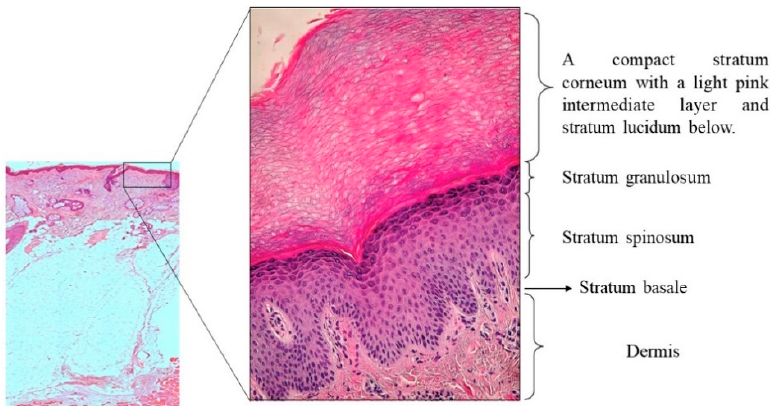
Figure 1. Structure of the skin end epidermis (courtesy of J. Czuwara, MD, Ph.D.). Magnification 200× (online, in color; black and white, in print).